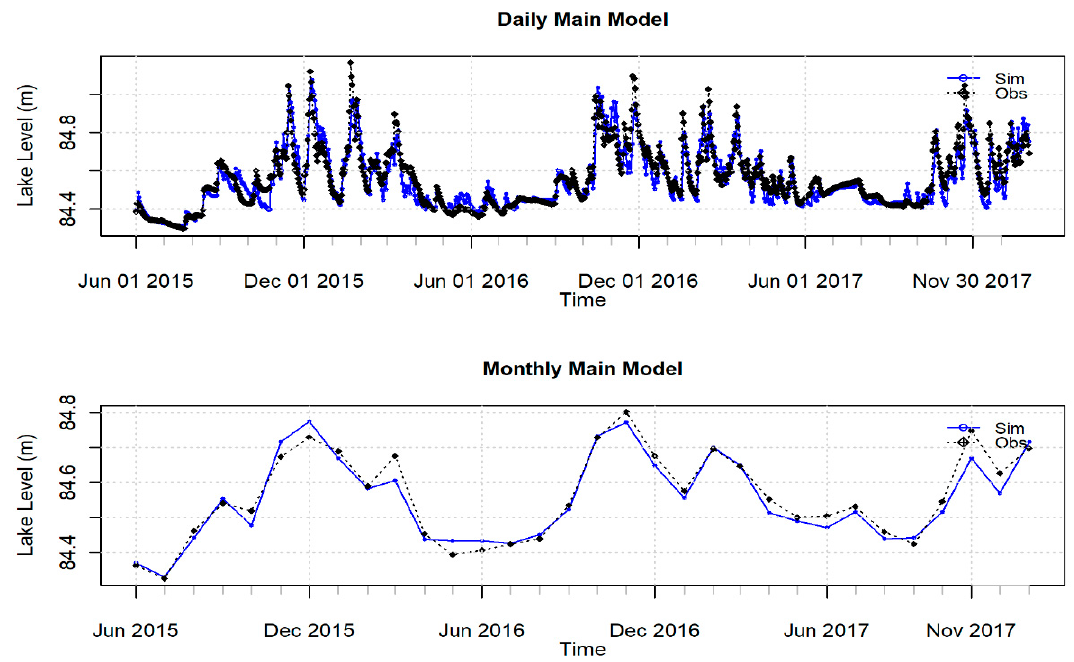
Figure 7. Daily and monthly simulated and observed lake level change for the calibration period.